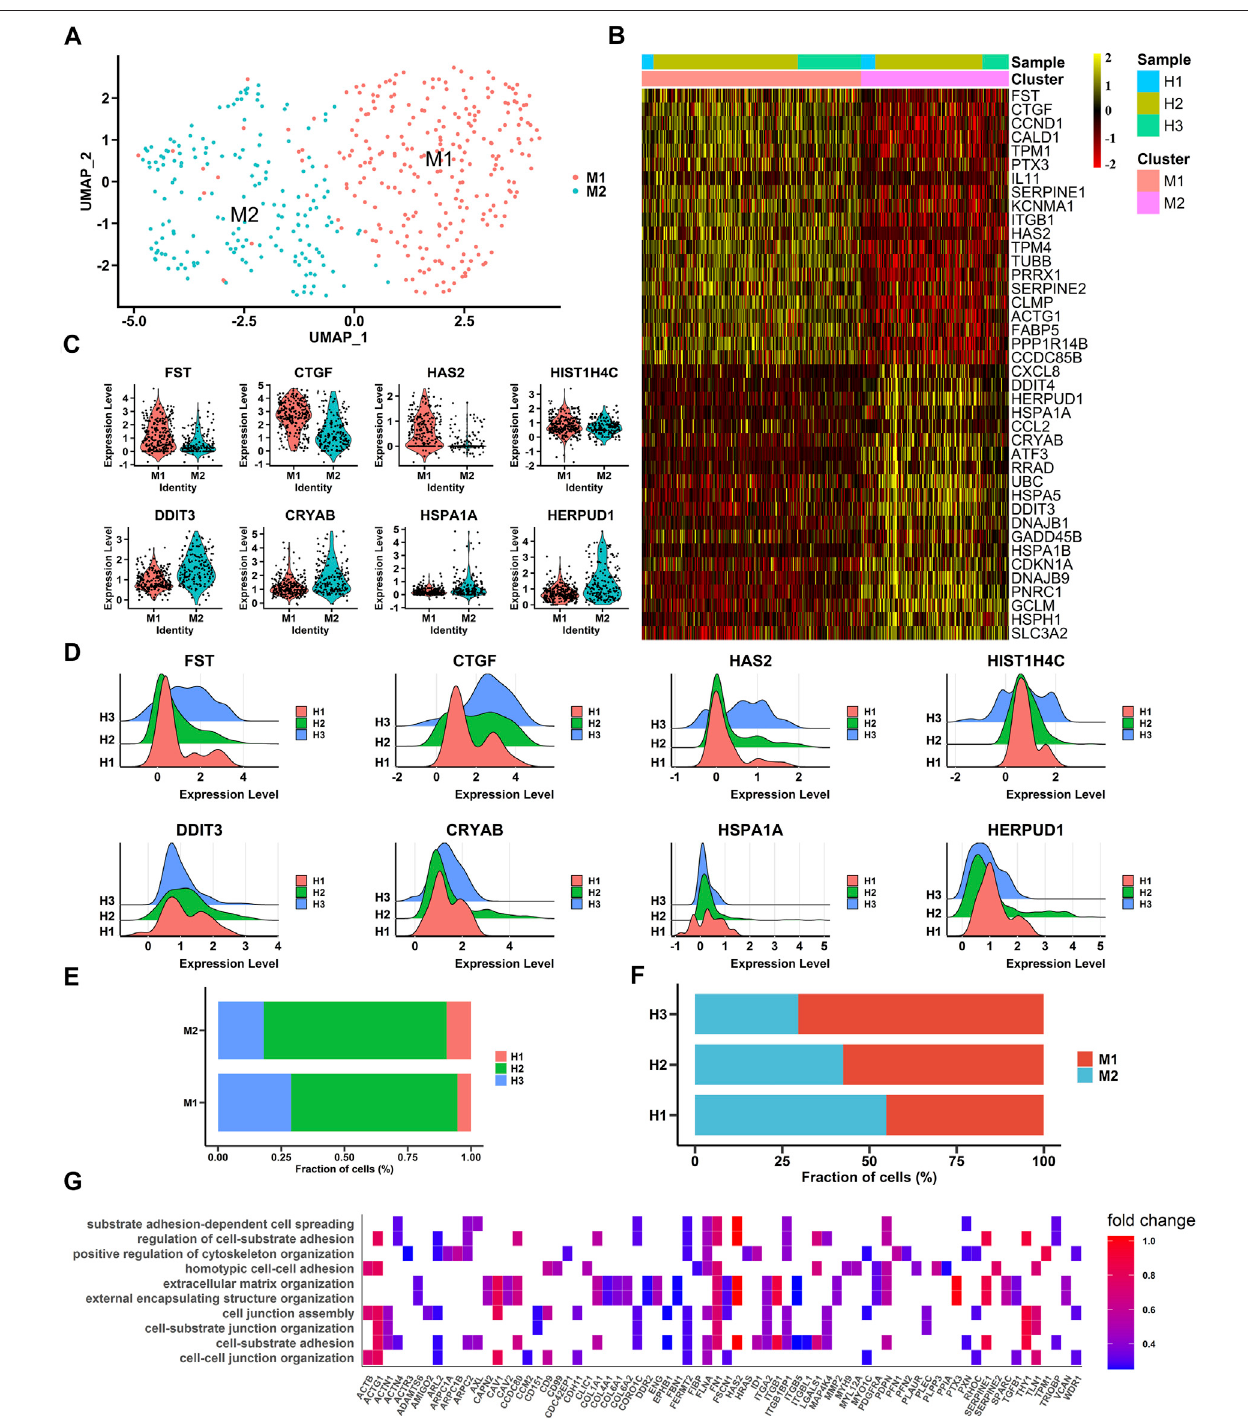
FIGURE 2 | Single-cell RNA-seq transcriptome pro fi ling of macular RPE (A) . UMAP plot shows the cell classi fi cation of macular RPE cell clusters in three samples (B). Heatmap of two macular RPE subpopulations. Columns are divided into two types of cells, rows represent gene names and can be used to identify two subpopulations. Theheatmapscalerepresents thenormalized expressionvalue (C). Violinplotsshowtheexpressionofdifferentiallyexpressedgenes,M1 (top) andM2 (bottom)(D). Ridgeplotsshowtheexpressionpatternsofdifferentiallyexpressedgenesinthreesamples.The X -axisshowsthelevelofgeneexpression.M1 (top) andM2 (bottom)(E). Theproportionofeachsampleineachcluster(M1,M2) (F). Theproportionofeachcluster(M1,M2)ineachsample (G). GeneOntology(GO)terms associated with genes with upregulated expression in the M1 subpopulation.